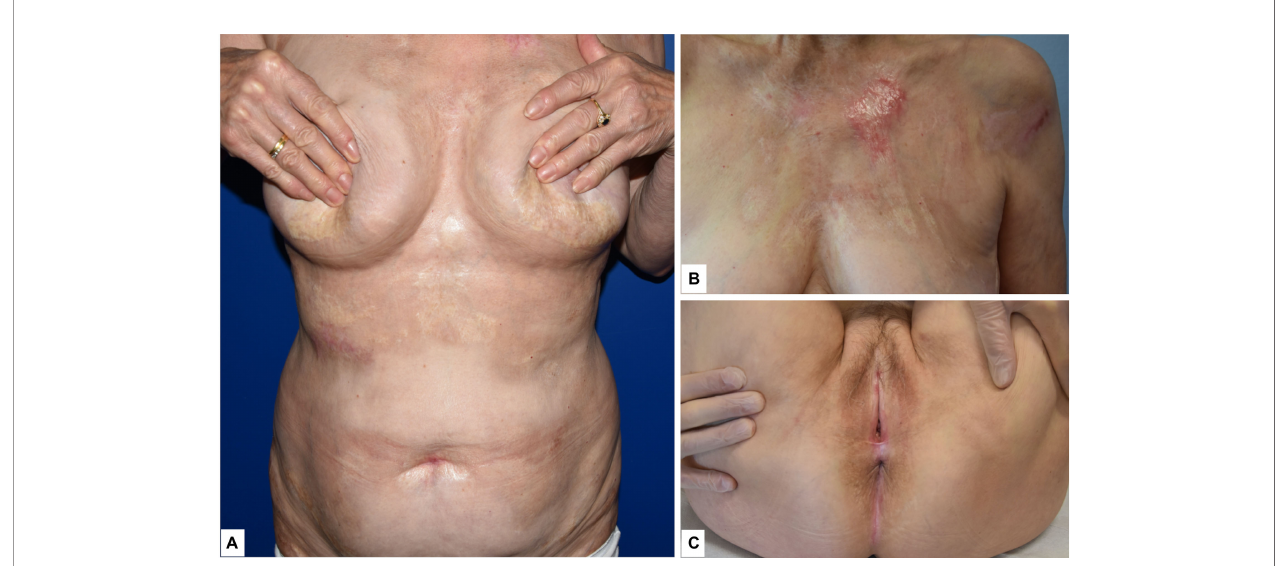
FIGURE 1 | (A) Whitish indurated plaques with slight erythematous border consistent with localized scleroderma; (B) detail of the patient ’ s trunk, where a whitish indurated lesion could be observed; (C) erythema and scarring around the anogenital area of the patient consistent with lichen